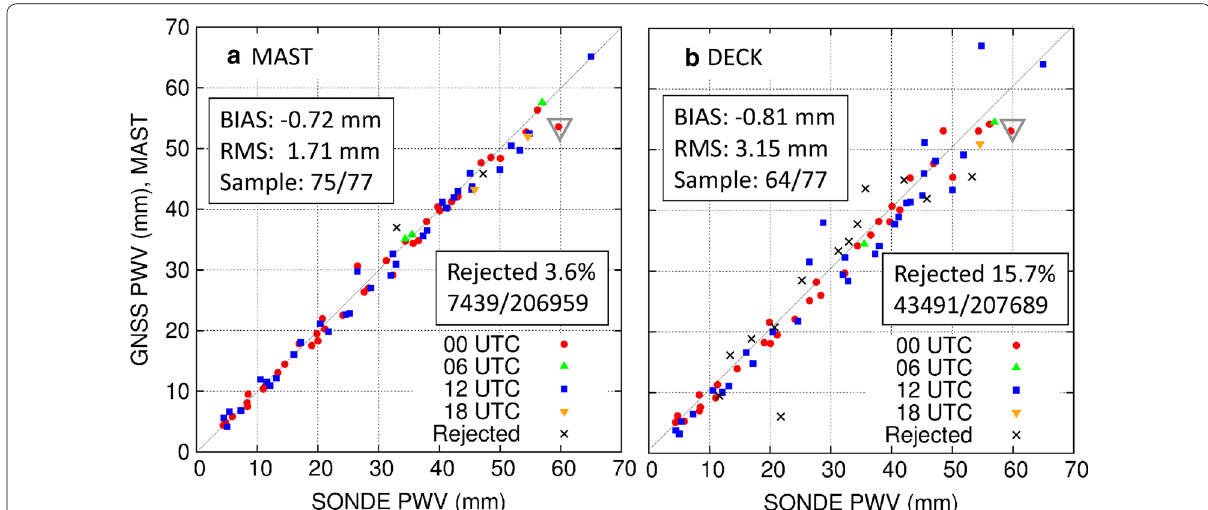
Fig. 7 Scatter diagrams of the differences in the GNSS PWV obtained from the MAST measurements versus the radiosonde observations. The red circle plot with the gray inverted triangle is a comparison with the radiosonde launched at 2331 UTC on June 10, 2017. The cause of the large differ- ence is discussed in “Discussion and